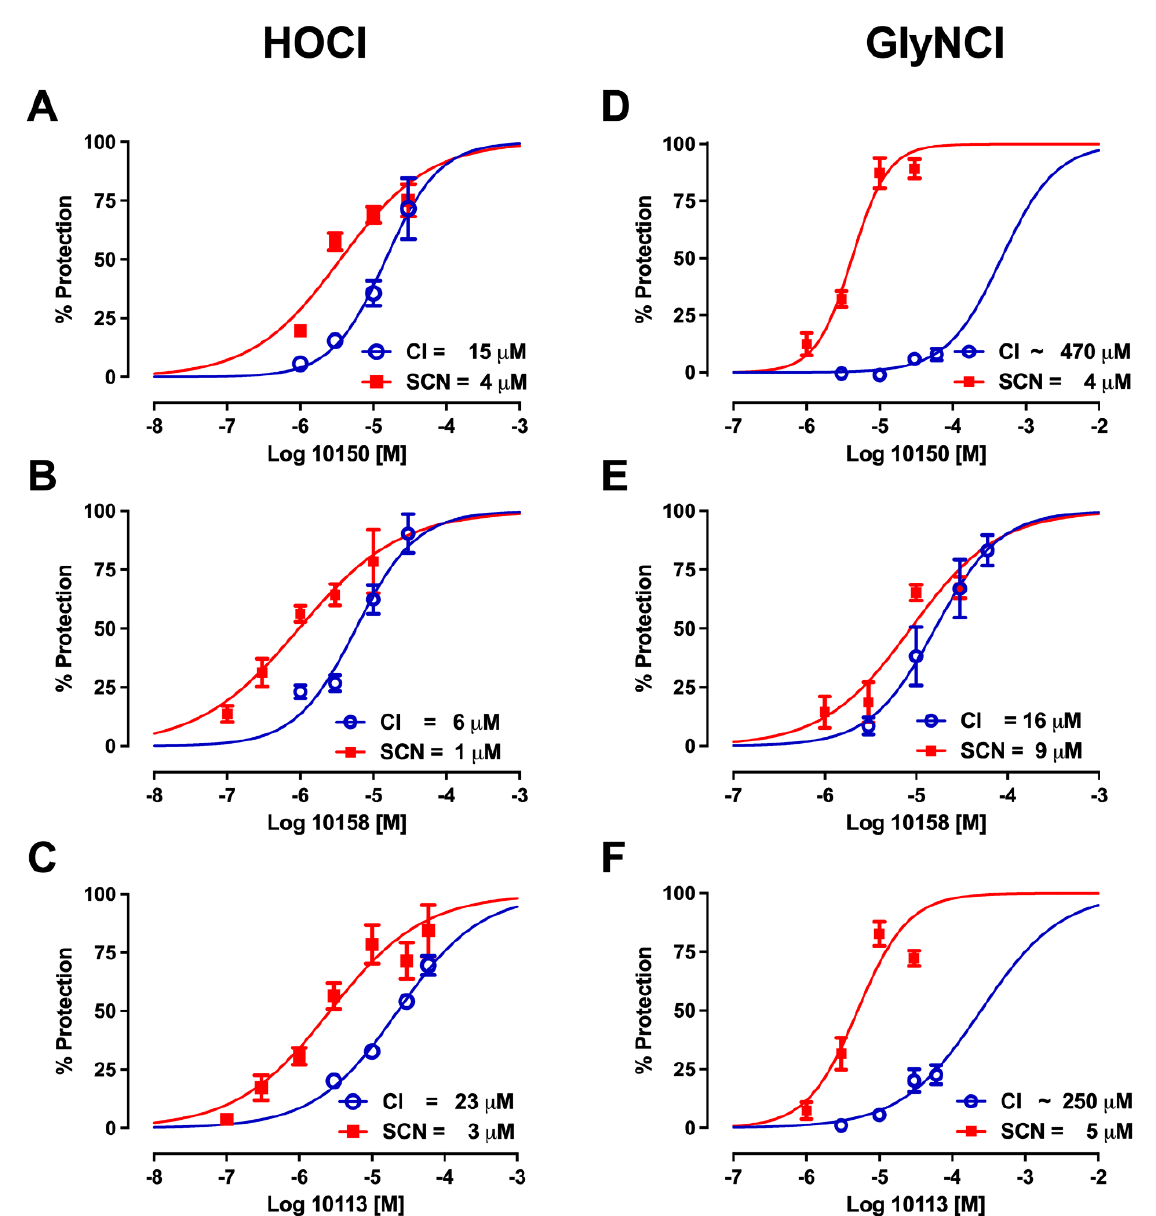
Figure 11. Manganese meso -porphyrins protect airway epithelium from hypochlorite (HOCl) and glycine chloramine (GlyNHCl)-induced injury, and thiocyanate increases their potency . Human bronchial epithelial cells (16HBE41o-) were treated for 30 or 60 min of either glycine chloramine ( D – F ) or HOCl ( A – C ) in PBS, then placed back in media containing manganese meso -porphyrins (MnPs), and cell viability was assessed 24 h later using the MTT assay. The 50% protective MnP concentrations (EC 50 ) were determined by non-linear